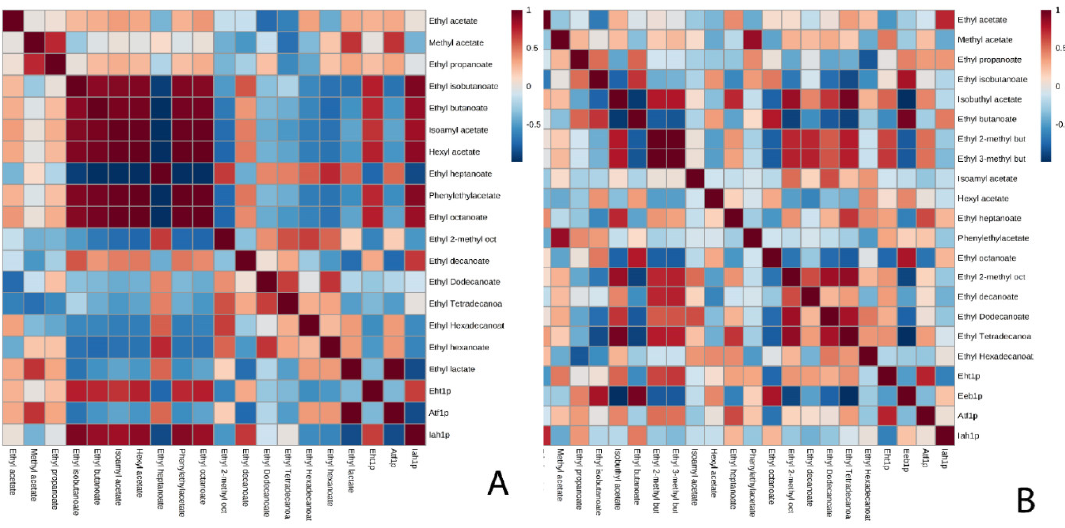
Figure 2. Matrix resulting from the analysis of correlations made for the condition without pressure in flor yeast ( A ) and in the P29 strain ( B ) with a level of significance of